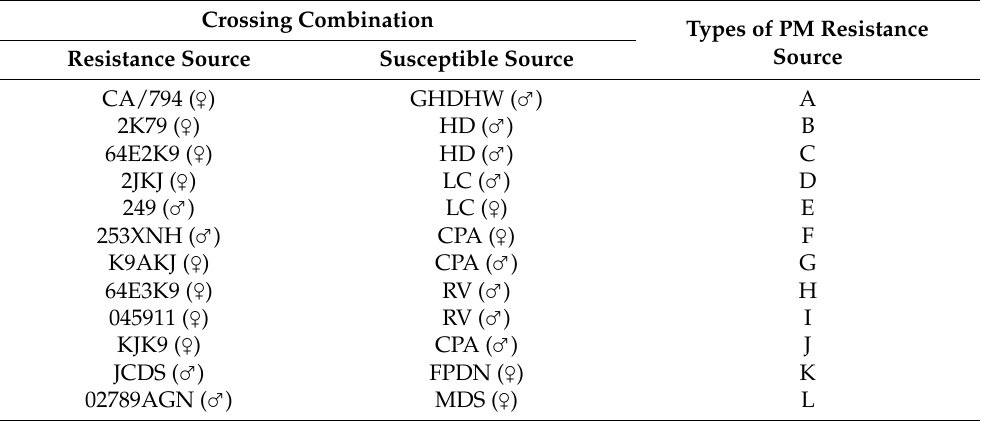
Table 1. List of PM resistant and PM-susceptible lines used for making inbred